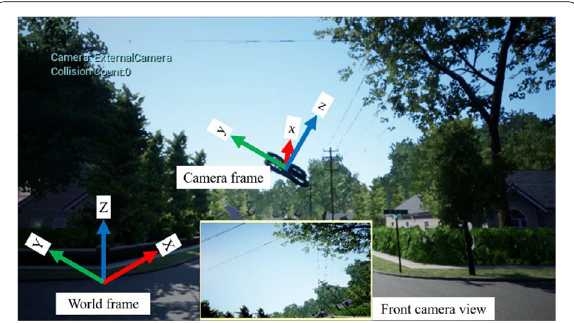
Fig. 1 Screenshot of AirSim with coordinate description. An IMU and a camera are equipped to the drone in the simulator. The purpose of the proposed neural network is estimating a gravity vector in the camera frame from a front camera